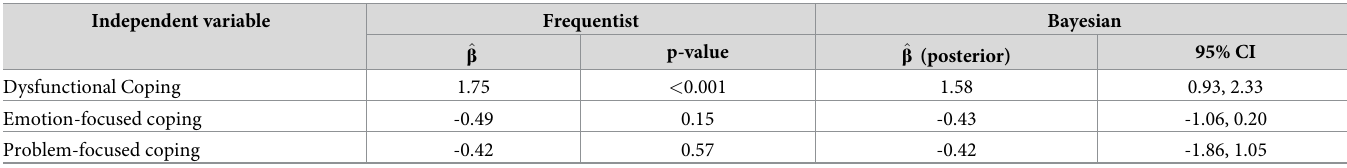
Table 7. Comparison between linear regression betas of frequentist and Bayesian